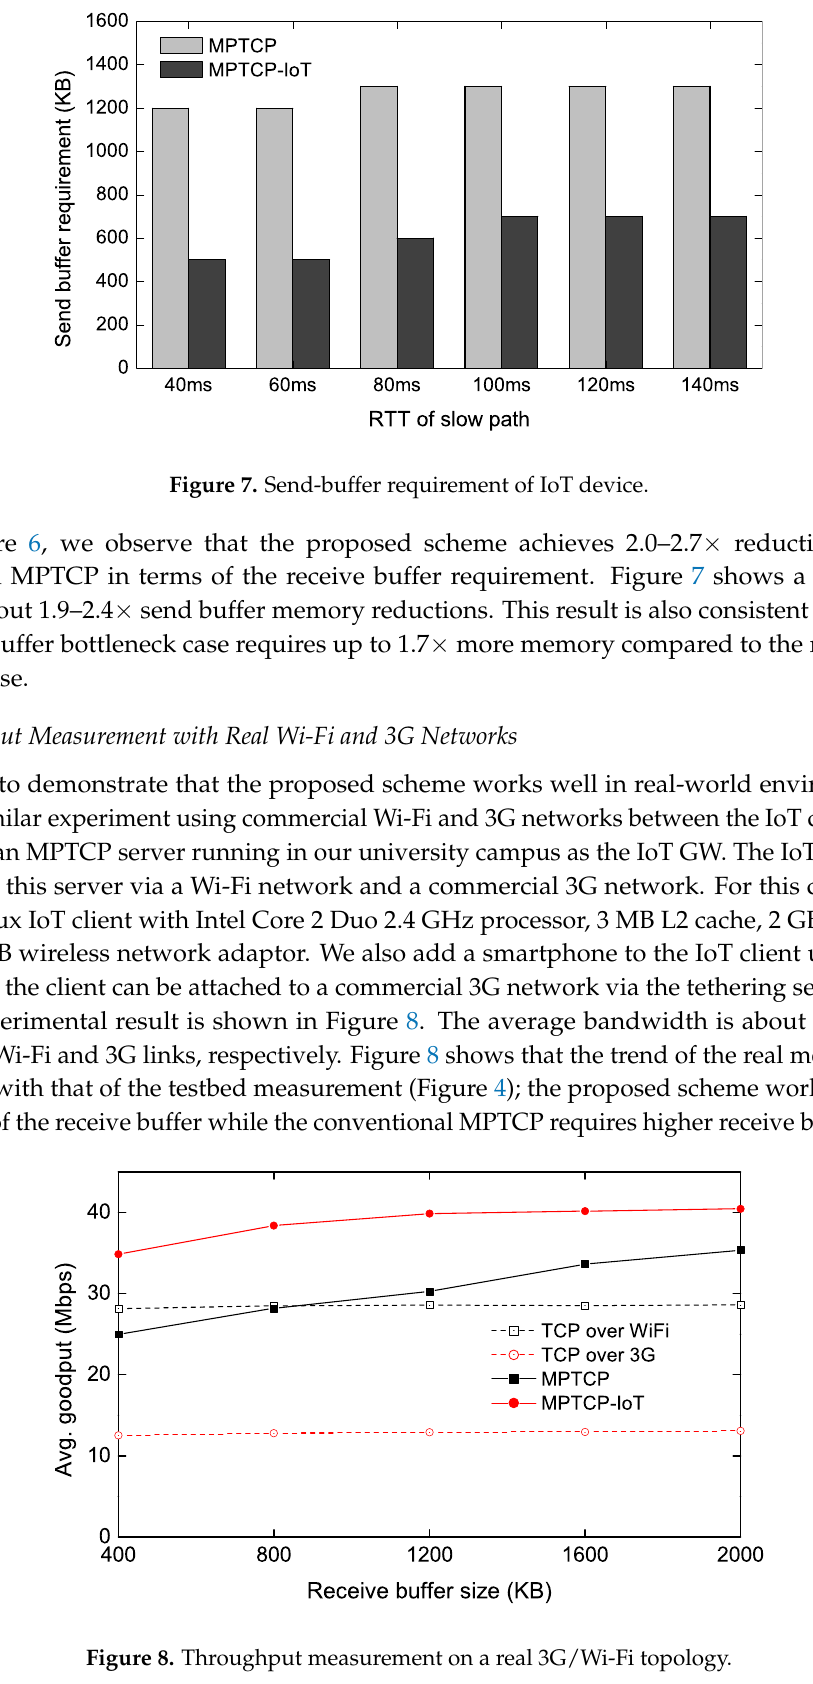
Figure 8. Throughput measurement on a real 3G/Wi-Fi